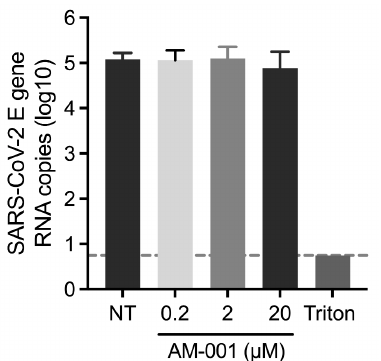
Figure 3. Evaluation of the virucidal properties of AM-001 against SARS-CoV-2 . SARS-CoV-2 vi- ral stocks were exposed to the indicated concentrations of AM-001, or to an equivalent concentration of DMSO (vehicle treated control NT), or to 0.1% Triton X-100 (positive control for virucidal activity) in cell culture medium for one hour at 37 °C. A 10 5 -fold dilution was subsequently used to titrate the infectivity of the treated viral stocks. Results are expressed as means ± SEM from one representa- tive experiment performed at least three times. The dotted gray line corresponds to the limit of de- tection of the TCID50 assay. Statistical analysis performed with one-way ANOVA with Dunnett’s multiple comparisons test revealed no significant difference between vehicle treatment (NT) and AM-001 treatment.